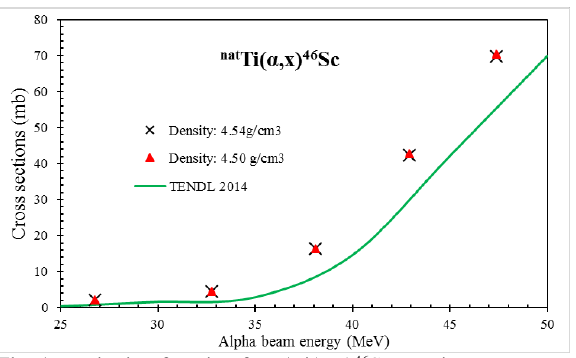
The experimental cross-sections of 46 Sc and 51